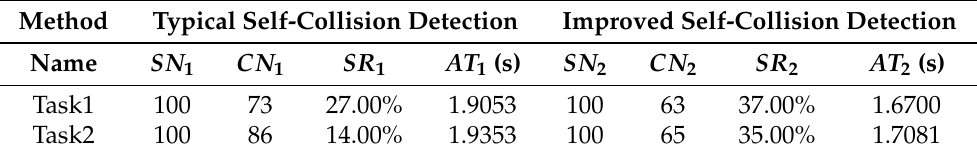
Table 4. Comparison performance of self-collision detection in practical